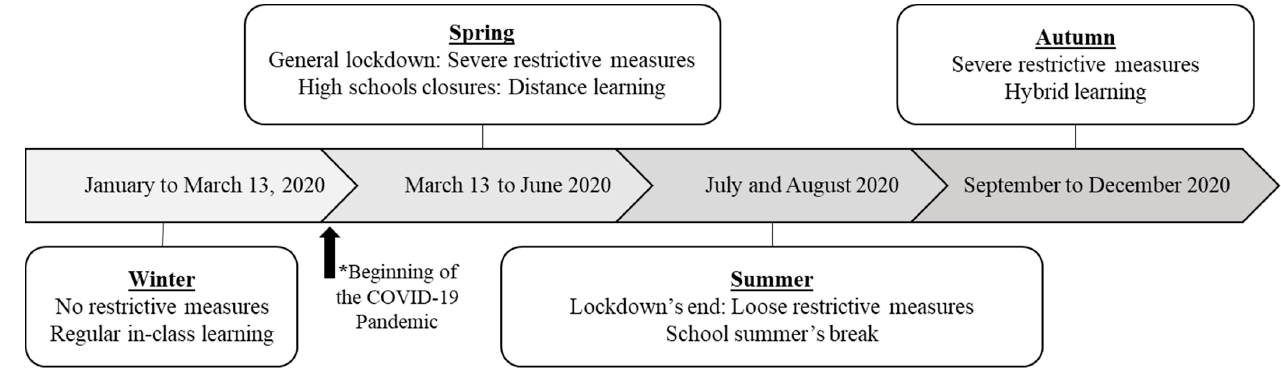
Figure 1. Timeline of the year 2020 in regard to the COVID-19 restrictive measures and the schooling situation. * In the Montreal area, restrictive measures due to the COVID-19 pandemic started on 13 March 2020.